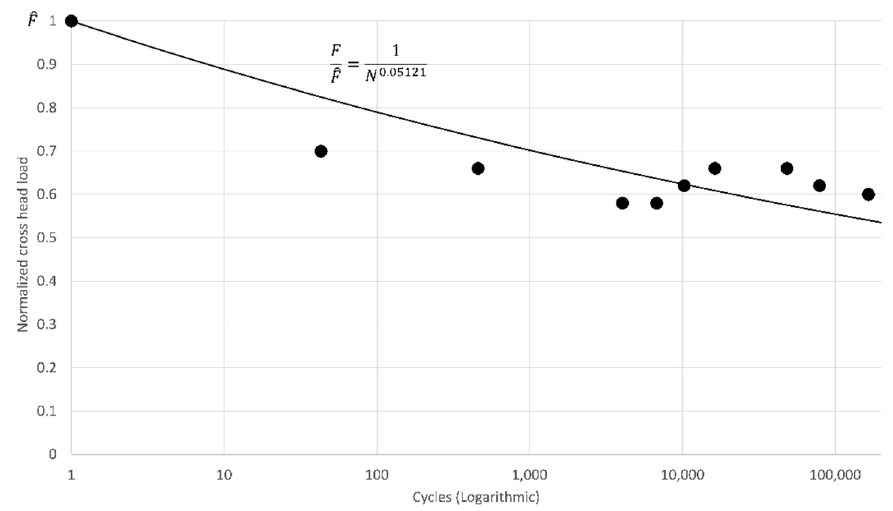
Figure 12. S-N curve for the shear component with data points.